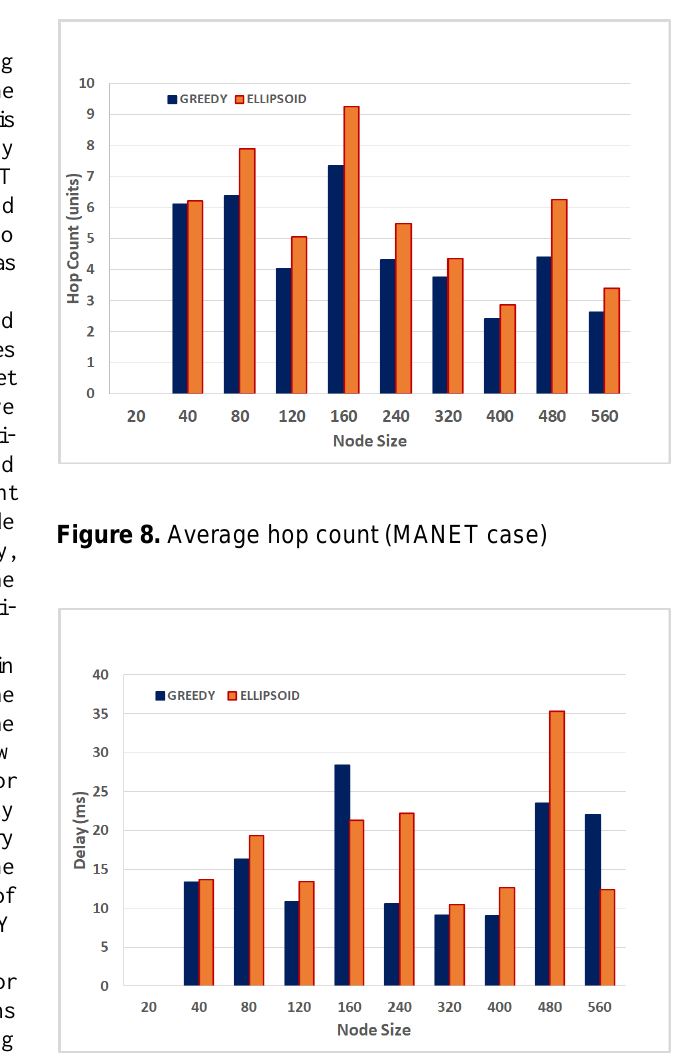
Figure 9. Average delay (MANET